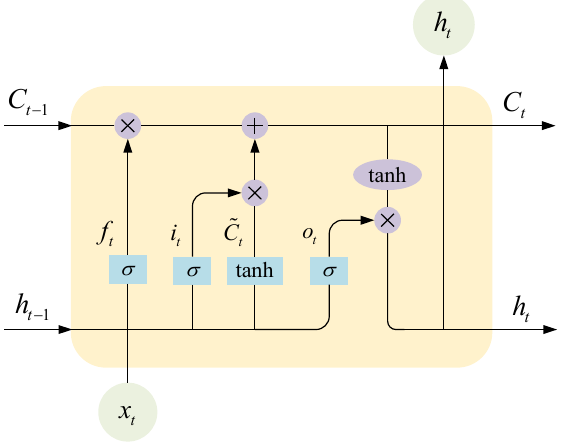
Figure 1. The LSTM structure diagram.